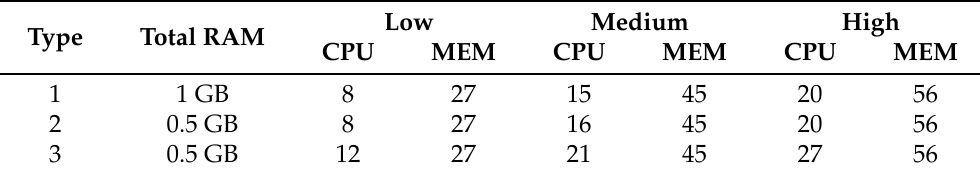
Table 6. Characterization of devices.